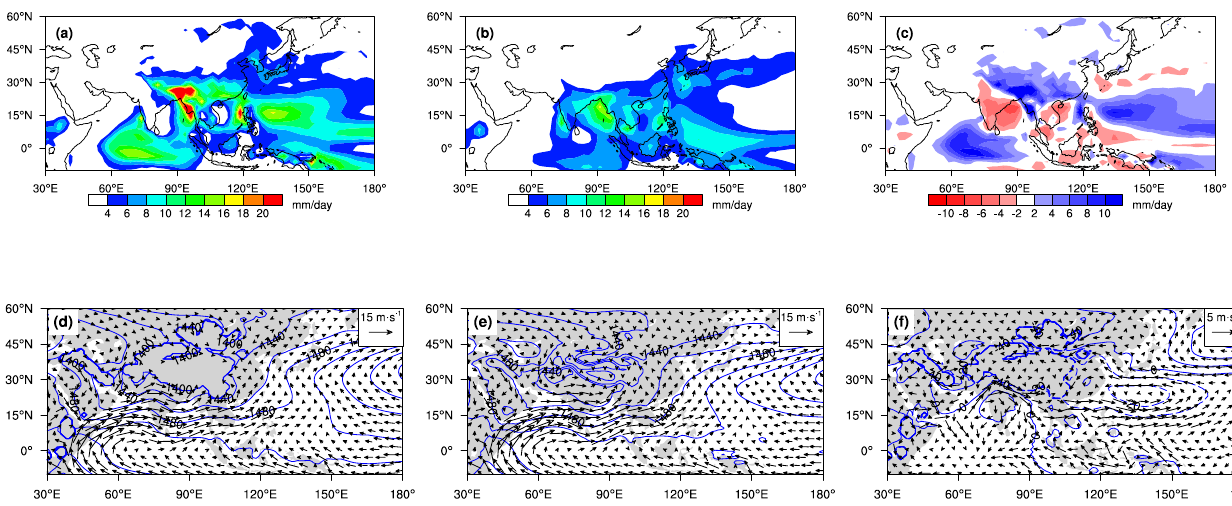
Fig. 2. (a) JJA precipitation in HiGAM (1983-2000, units: mm/day). (b) JJA precipitation from GPCP 2.5 × 2.5 monthly data (1983–2000, units: mmday − 1 ). (c) Difference in JJA precipitation (HiGAM minus GPCP) during 1983–2000 (units: mmday − 1 ). (d) JJA 850hPa geopo- tential height (contour, units: gpm) and wind (vector, units: ms − 1 ) in HiGMA (1983–2000). (e) JJA 850hPa geopotential height (contour, units: gpm) and wind (vector, units: ms − 1 ) from ERA40 (1983–2000). (f) Difference in JJA 850hPa geopotential height and wind (HiGAM minus ERA40).